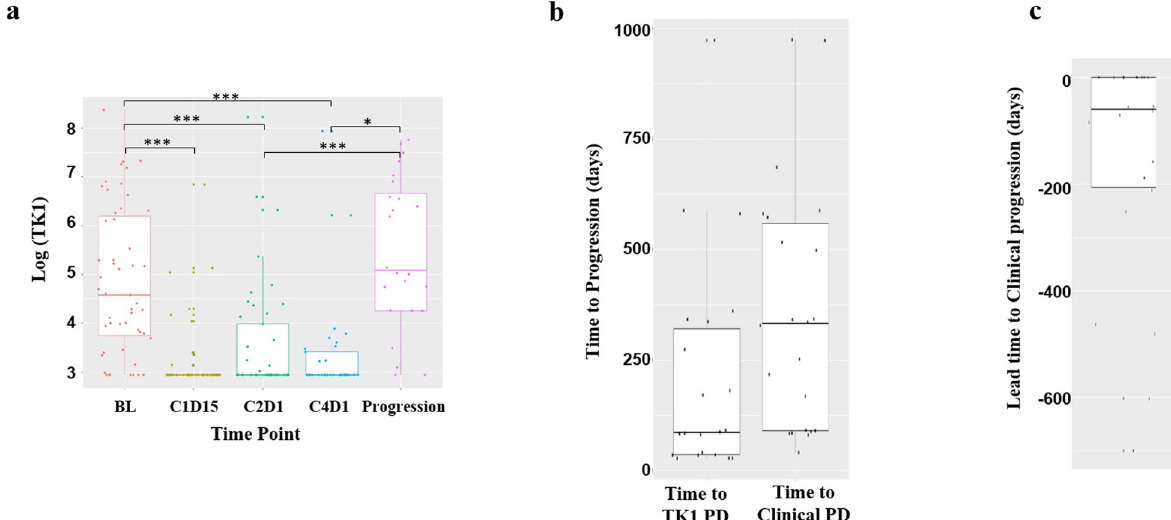
Fig. 2 Serum TK1 activity over time. a Box plot of log (sTK1 Du/L) along the 5-time points indicated. b Time to progression by TK1 increase from the previous time point (sTK1 PD) or by RECIST/investigator decision (Clinical PD). c The lead time from TK1 progression to clinical/RECIST progression. BL baseline, C1D15 cycle 1 day 15, C2D1 cycle 2 day 1, Progression PFS events that included RECIST progression ( n = 17) and investigator decision ( n = 7). The center horizontal line of the box plot indicates the median, while the box limits indicate the upper and lower quartiles. The box-plot whiskers show a 1.5× interquartile range. Those points outside the whisker line are indicated as outliers. * p < 0.05, *** p < 0.001.